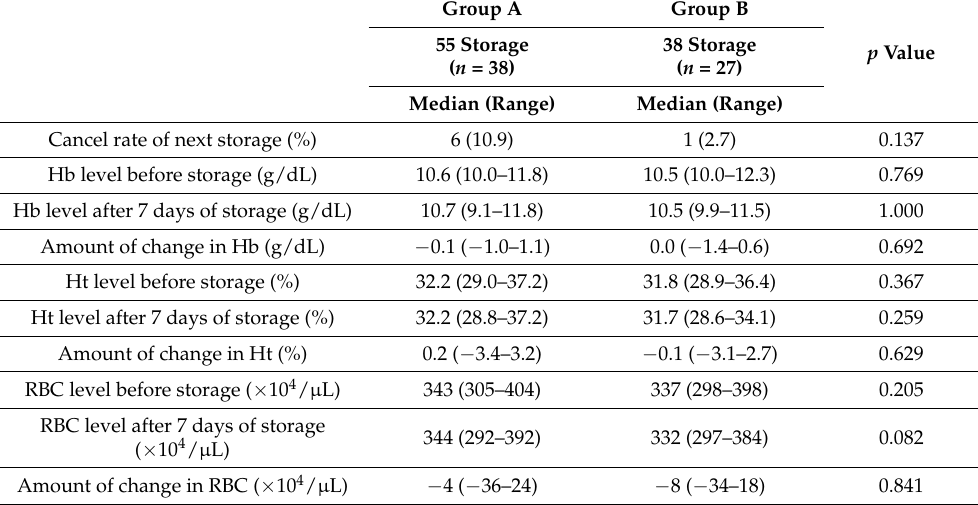
Figure 1. The dot-plot diagram shows the distribution of hemoglobin values ( a ) before the initial storage; ( b ) seven days after the initial storage; ( c ) before the second or subsequent storage; ( d ) seven days after the second or subsequent storage. ** p < 0.01, N.S: not significant. Table 4. Blood cell counts and differences in the second and subsequent